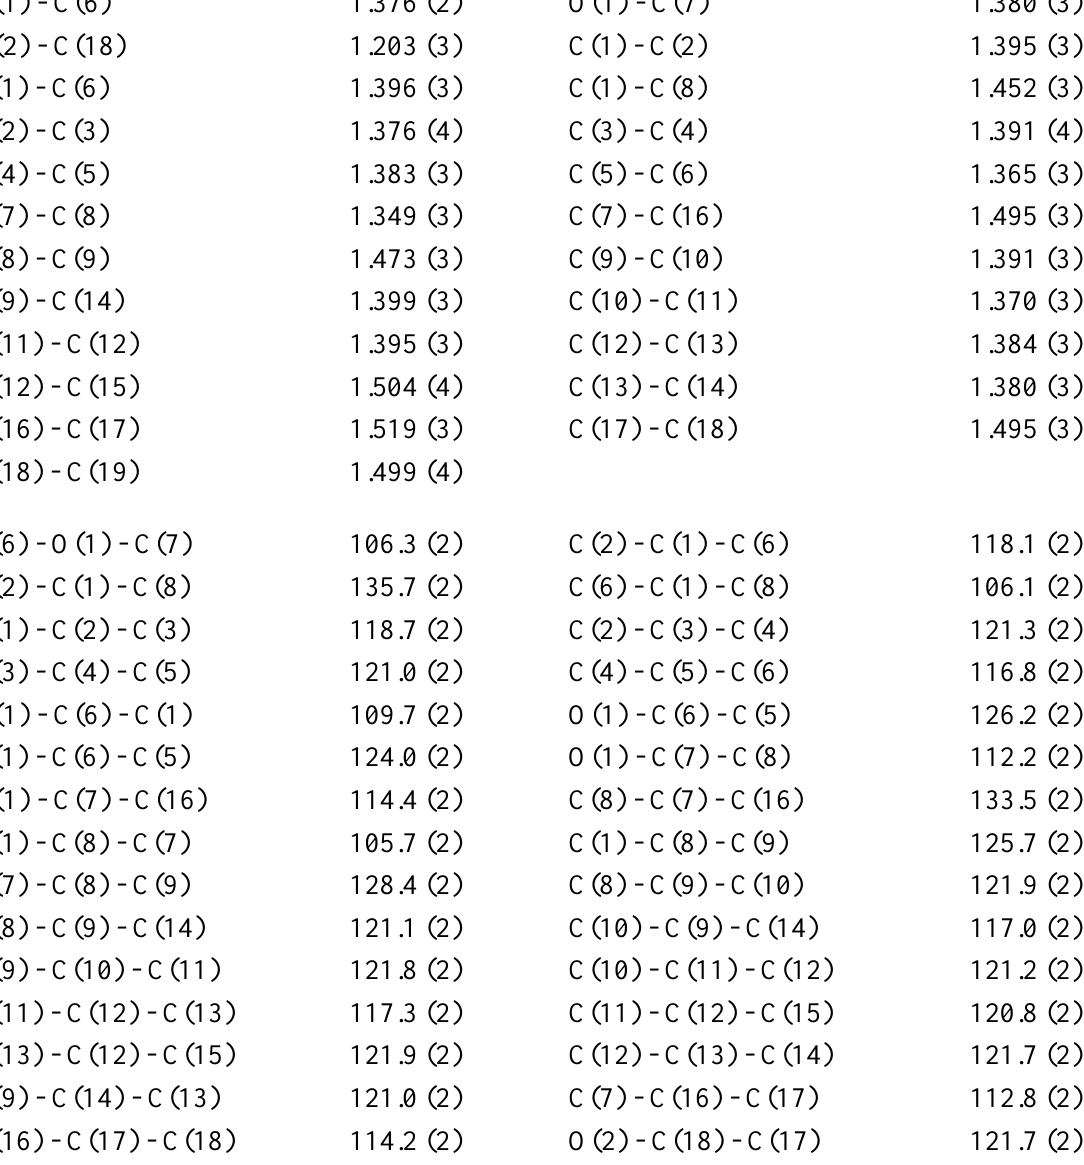
Table 7. Bond lengths (A) and angles